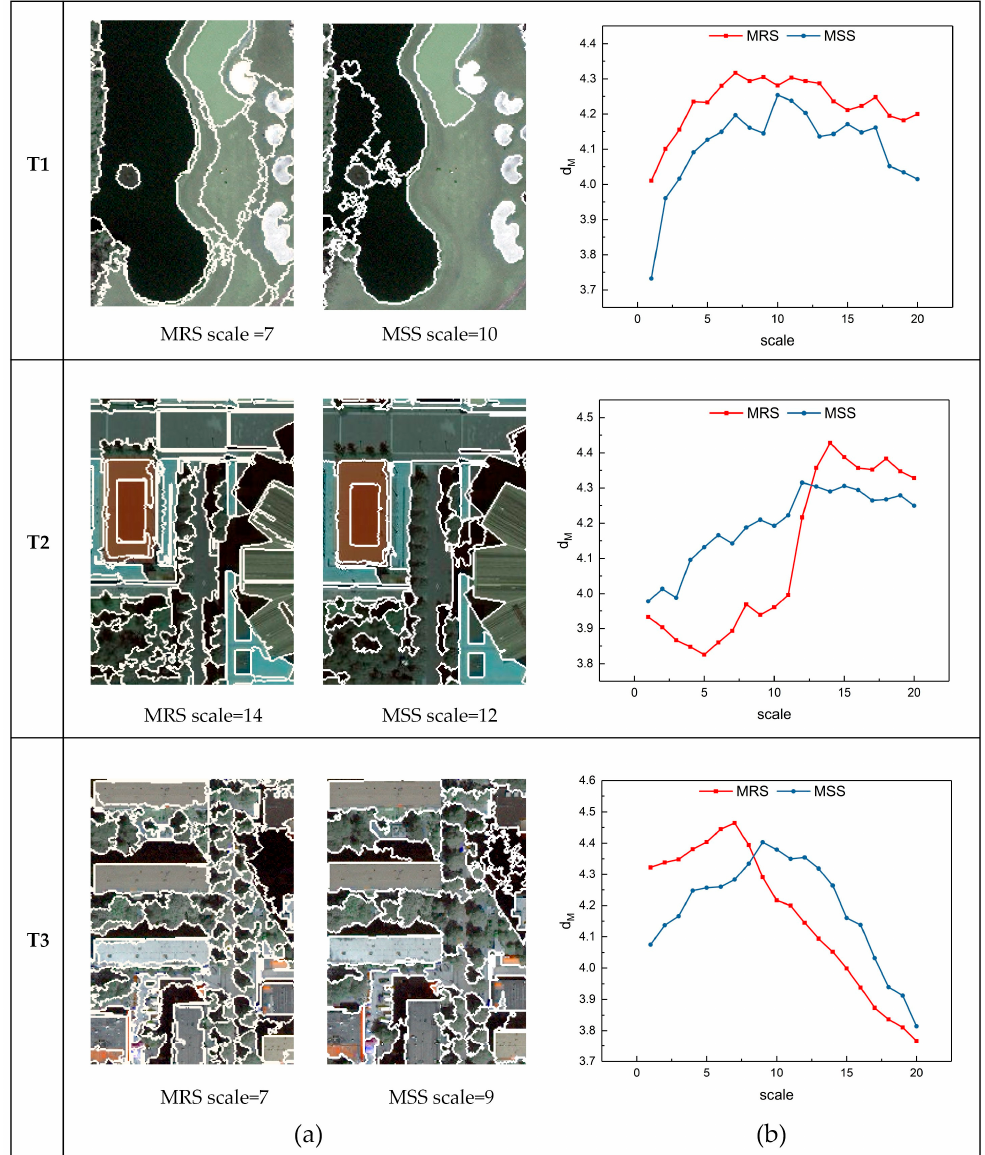
Figure 12. ( a ) The optimal segmentation results of MRS and MSS indicated by the (cid:1856) (cid:3014) method for T1, T2 and T3; and ( b ) the plots of the (cid:1856) (cid:3014) values for MRS and MSS at different